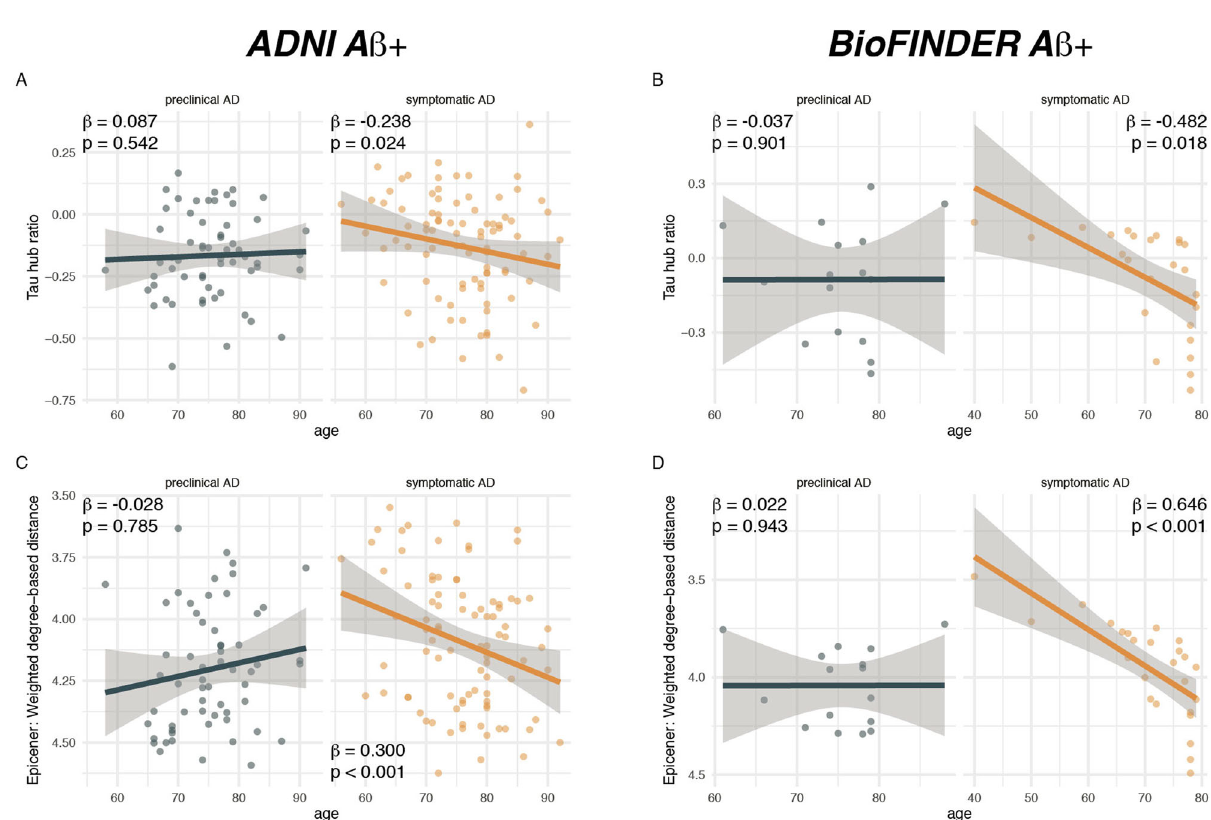
Fig. 2 | Younger age is associated with a higher hub ratio in symptomatic AD. Scatterplots illustrating the association between age and the tau hub ratio for A β + subjects of the A ADNI ( N =147) and B BioFINDER sample ( N =41), strati fi ed